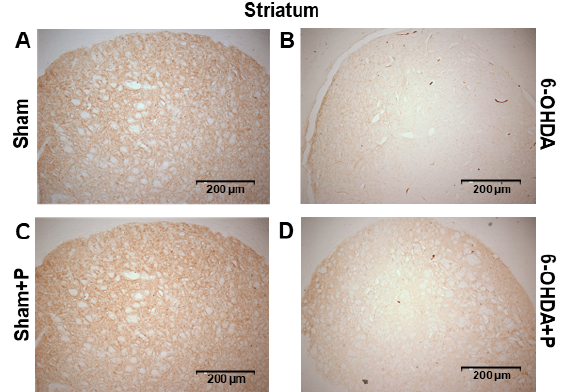
Figure 7. Representative striatum images of tyrosine hydroxylase (TH)-immunoreactive sections. TH-positive striatal fibers in ( A ) sham; ( B ) 6-OHDA; ( C ) sham + P; ( D ) 6-OHDA + P.